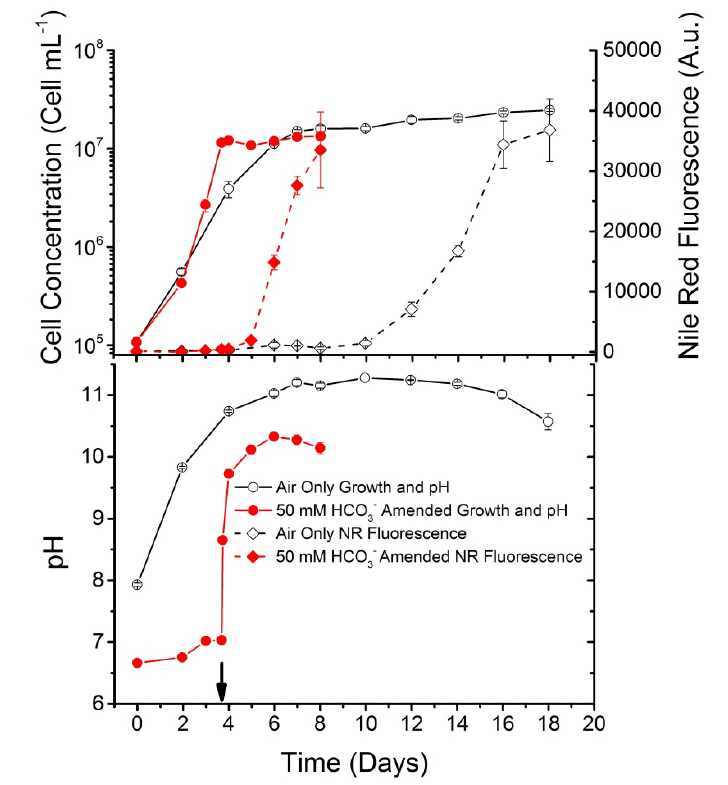
Figure 1. Scenedesmus sp. WC-1 mean and standard deviation of cellular concentration, total Nile Red fluorescence, and pH of cultures aerated with ambient air and cultures which were sparged with 5% CO ( v / v , in air) until near nitrate depletion, at which time they were amended 2 with 50 mM sodium bicarbonate and switched to ambient air. Arrow indicates time of the gas sparge change and bicarbonate addition. Growth was maintained in unbuffered Bold’s basal medium illuminated with a 14:10 L/D cycle ( n = 3). Figure adapted from